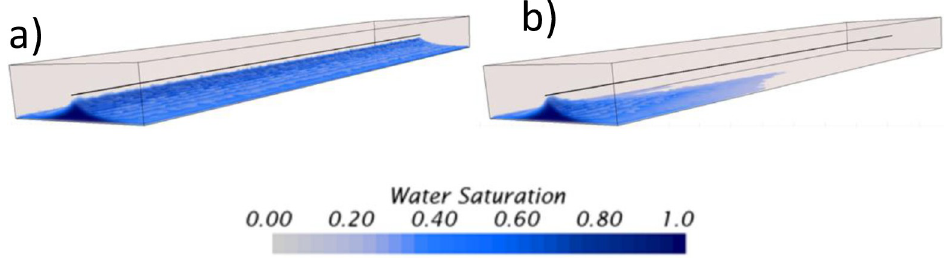
Fig 8. Dynamics of the water movement near the wellbore for the viscosity sensitivity analysis, a) at μ oil = 0.001 Pa � s, b) at μ oil = 100 Pa � s. 3D renders taken at the breakthrough